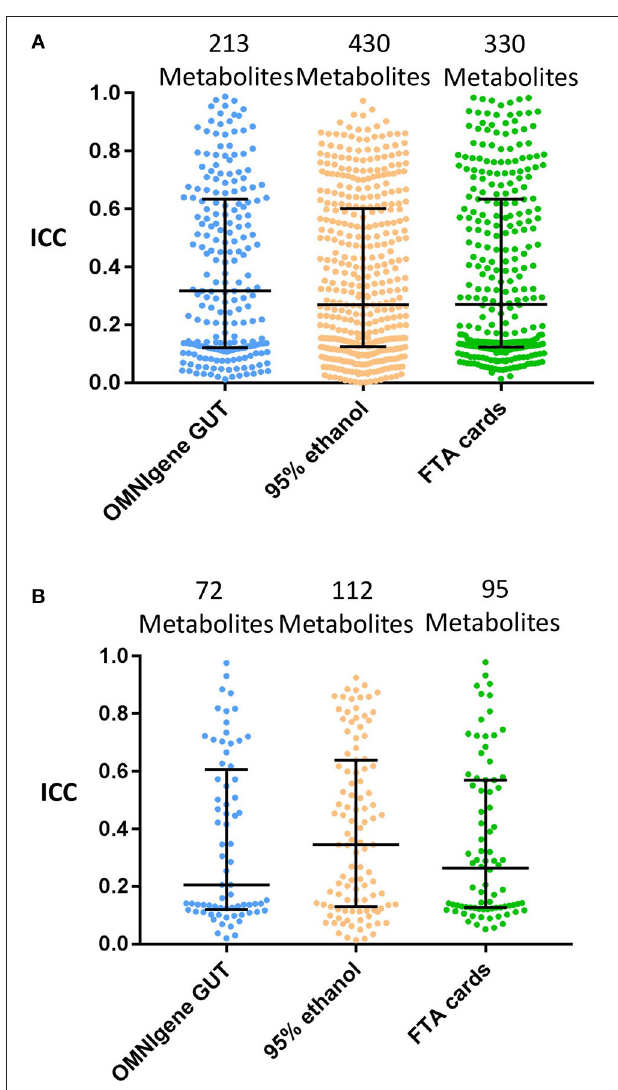
FIGURE 3 | The concordance of metabolite detection by different fecal collection methods. Stool samples collected by the indicated methods were compared with the gold standard of immediate freezing for metabolite detection estimated the ICCs at ≥ 75% metabolites detectability level. Log10 transformation and Quantile normalization were used. Missing values were imputed with ½ minimum value for a given metabolite within one method. Highlighted medians and IQRs. (A) All Metabolites shared by GS and method. (B) Known (Named) Metabolites shared by GS and method.